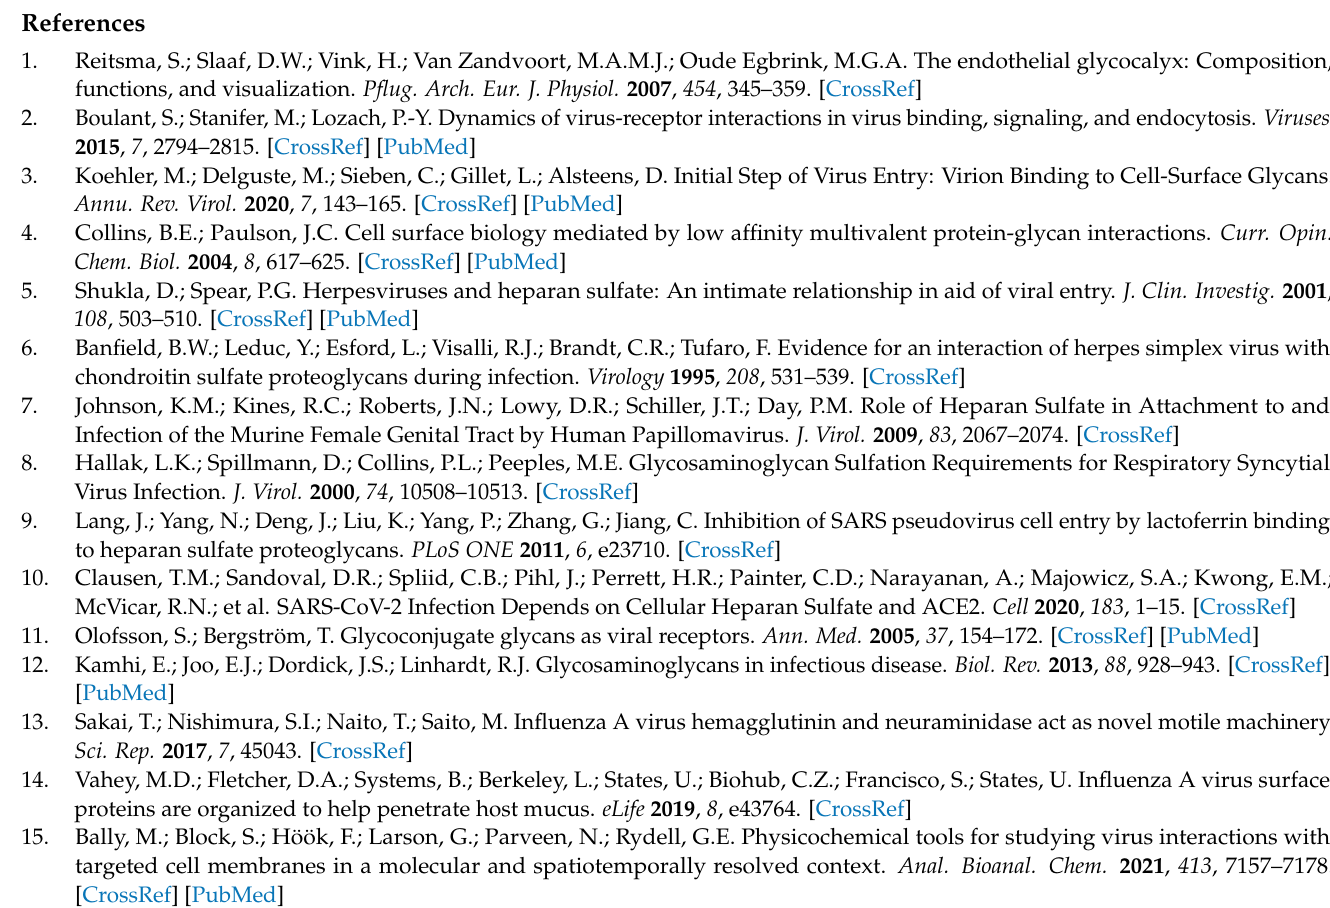
three motion types; Figure S5: Influence of the nature of the glycosaminoglycans on the first segment of HSV-1 (KOS) interaction with the CHO cell surface; Figure S6: Influence of the nature of the glycosaminoglycans on the initial interaction of HSV-1 with the HaCaT cell surface; Figure S7: Influence of the mucin-like domain on the first segment of HSV-1 (KOS) interaction with the HaCaT cell surface; Figure S8: Linear regression analysis for binding quantification via qPCR; Figure S9: Number of attached HSV-1 virus particles at the CHO cell surface; Movie S1: Representative movie for each